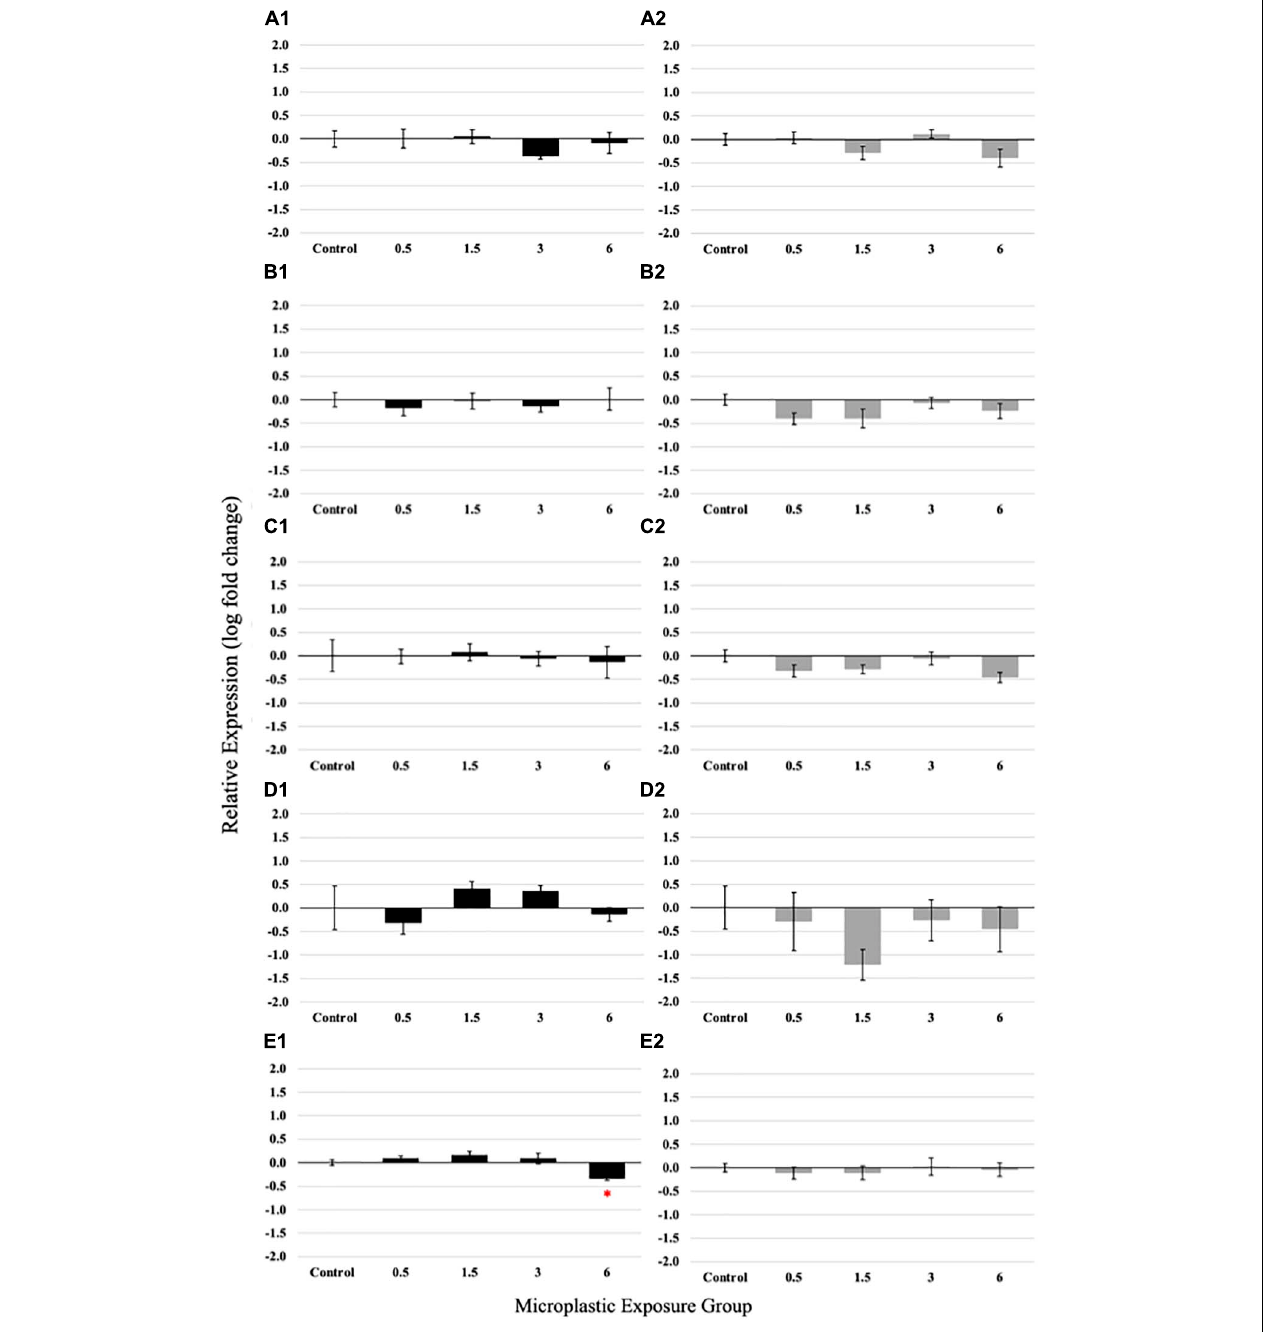
FIGURE 5 | Relative expression of Glucagon (A1) , Peptide YY (PYY) (B1) , Trypsinogen (TRP) (C1) , Insulin (ISN) (D1) , and solute carrier family 6 member 6 (slc6a6) (E1) in larvae medaka after 21 days of exposure to 0 (control), 0.5, 1.5, 3, and 6 fibers/fish per day. Relative expression of Glucagon (A2) , Peptide YY (B2) , Trypsinogen (C2) , Insulin (D2) , and slc6a6 (E2) in juvenile medaka after 21 days of exposure to 0 (control), 0.5, 1.5, 3, and 6 fibers/fish per day. Data are presented as mean relative expression ± standard error (ANOVA, * p < 0.05, n = 5 replicates/pools of 5 individuals per concentration).